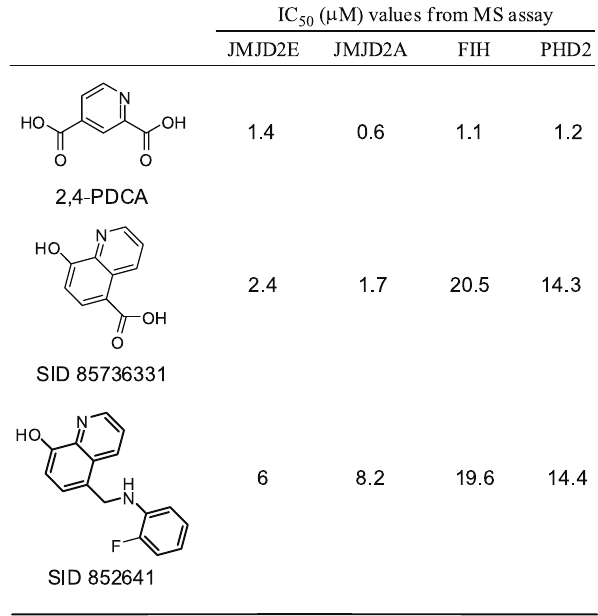
Figure 6. Inhibitor screening against JMJD2 and other human 2OG oxygenases. IC 50 values from MALDI-TOF MS assay. See Figure S4 for representative concentration-response curves and MALDI-TOF mass